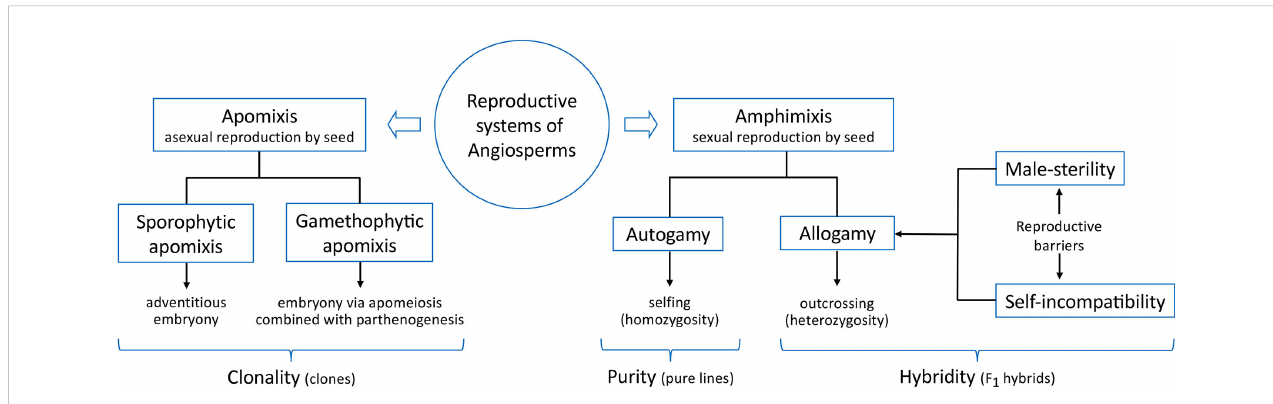
FIGURE 1 Main reproductive systems and barriers in crop plants: apomixis determines clonal populations by means of either sporophytic embryony or gamethophytic embryony, whereas amphimixis through sel fi ng and outcrossing is exploited for breeding pure lines and F1 hybrids,